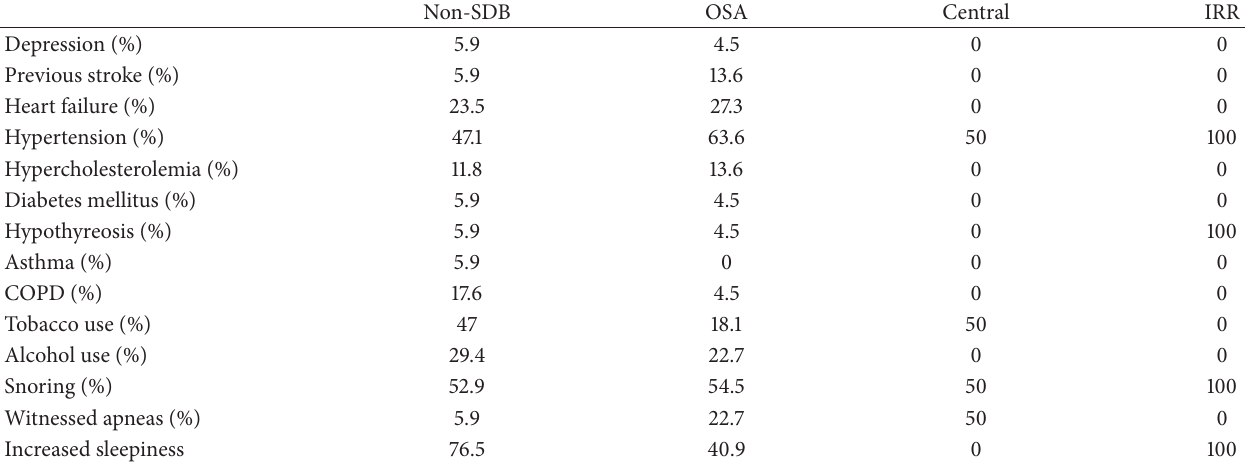
Table 5: Demographic parameters of the 42